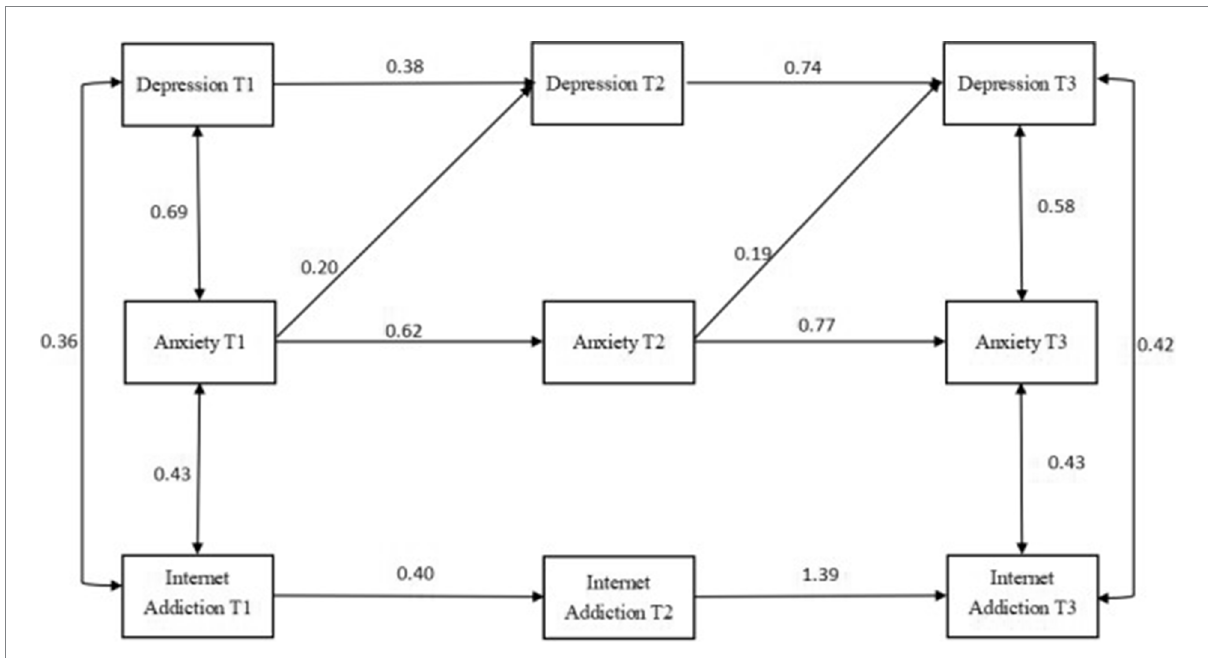
FIGURE 4 Cross-lagged analysis of depression, anxiety, and Internet addiction among women. T1 is the baseline data and T2 and T3 are follow-up data. The solid line indicates statistical